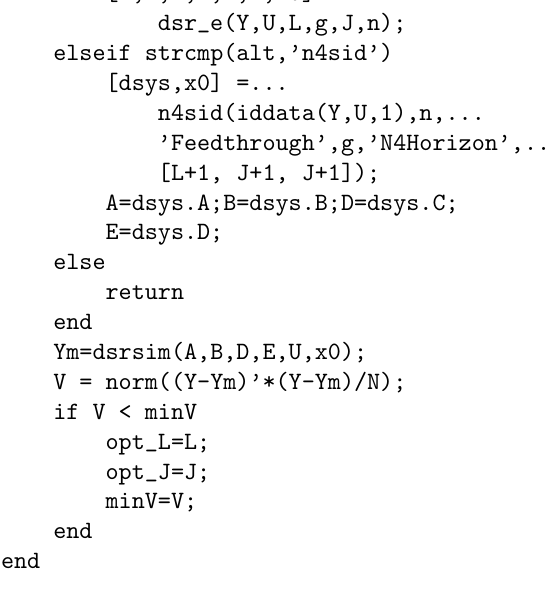
Figure 1: Example 4.1. The figure shows the mean of the criterion V (defined in Eq. (33)) for dsr e , dsr and n4sid based on random dis- crete space model Monte Carlo simulations.